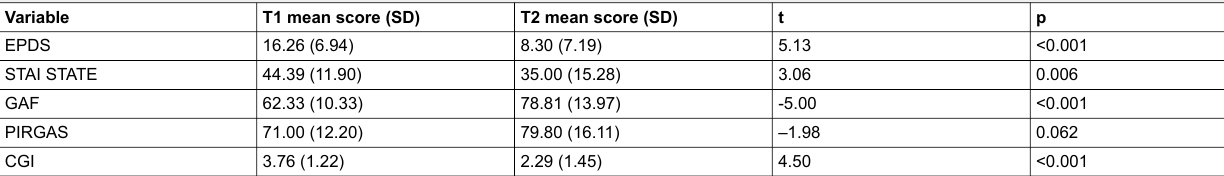
Table 3: Comparison of baseline and post-treatment scores for completers (n = 23).